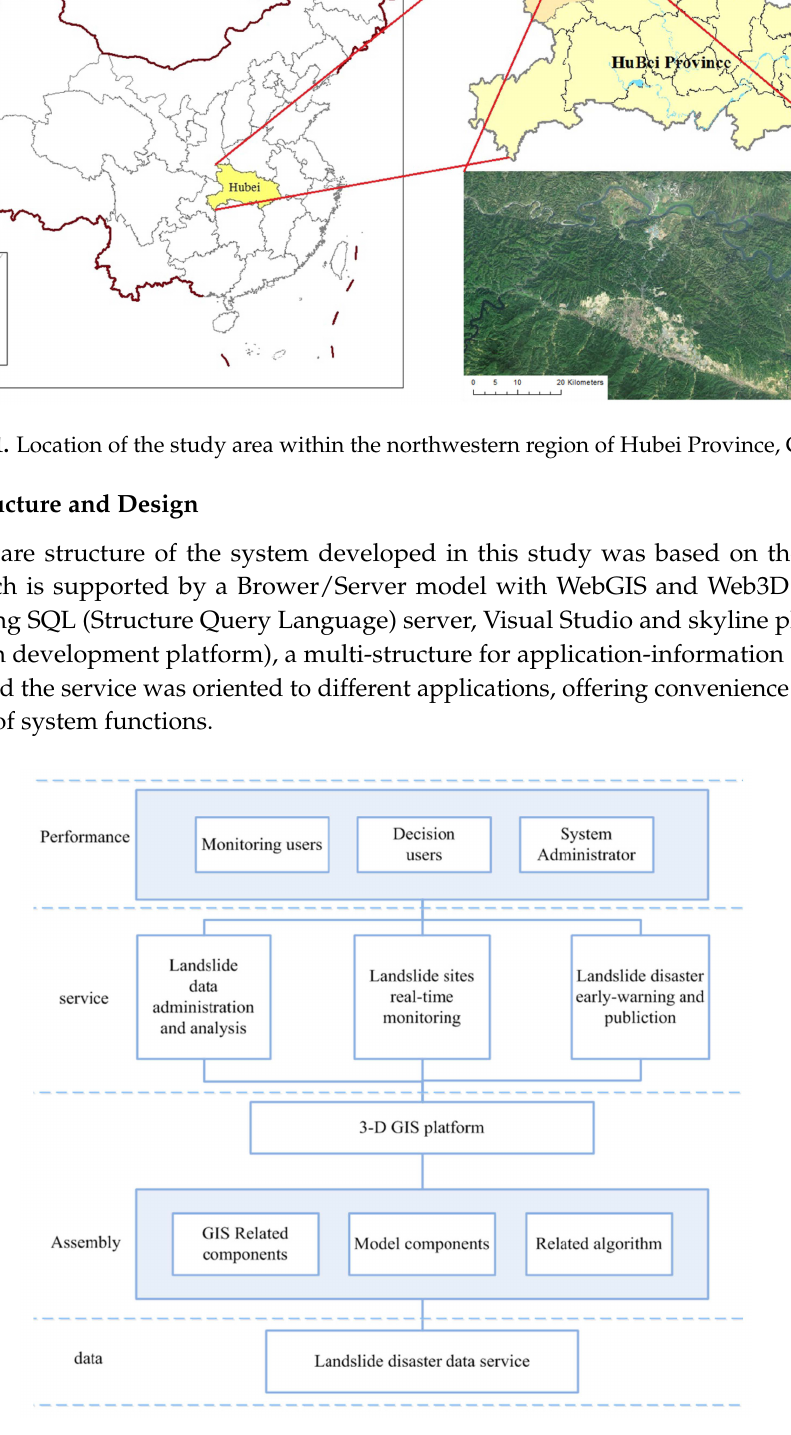
Figure 2. Software structure of the landslide monitoring and early warning